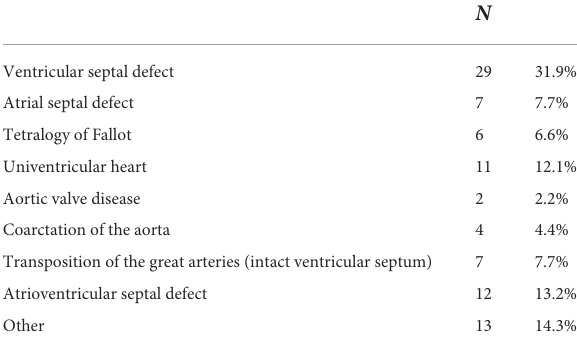
TABLE 4 CHD diagnoses of microcephalic